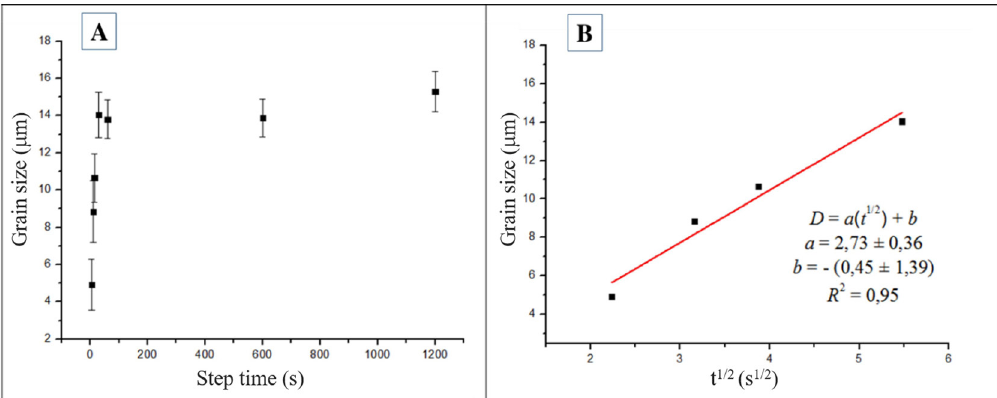
Figure 7. A) Grain size of polygonal ferrite as a step time function; B) Fitting of Zener equation to the first stage of ferrite grain growth. Step temperature: